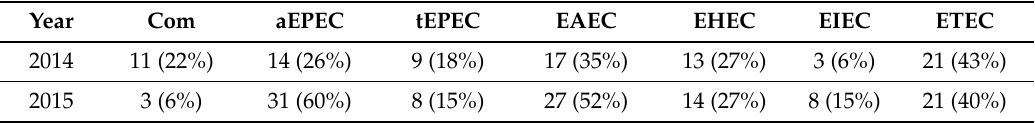
Table 4. Relative percentages (%) of E. coli strains identified by PCR